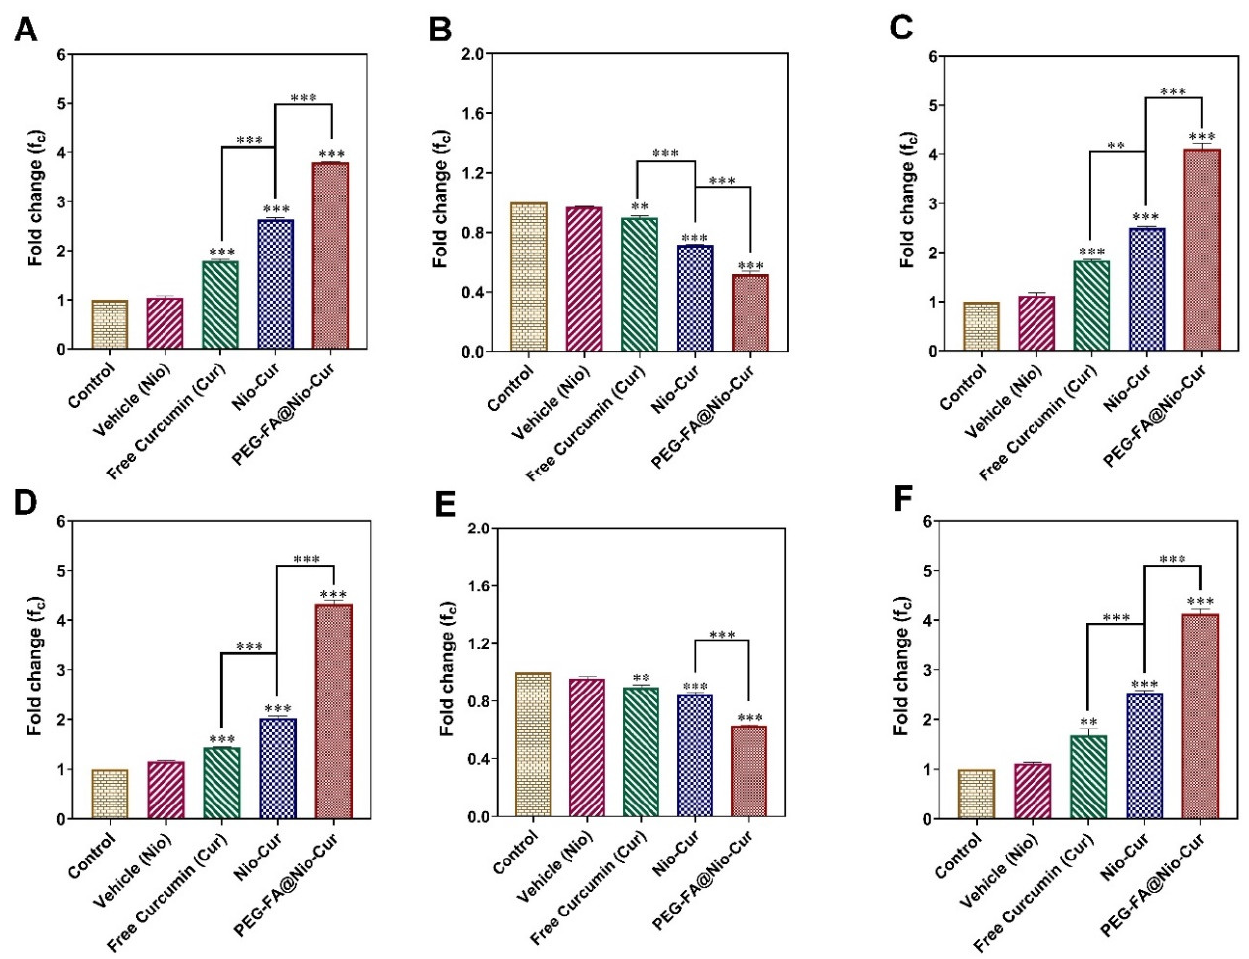
Figure 6. ( A ) Expression levels of Bax, ( B ) Bcl2, and ( C ) p53 genes in MCF7 cells and ( D ) Expression levels of Bax, ( E ) Bcl2, and ( F ) p53 genes in 4T1 cells after those breast cancer cells were exposed to Vehicle (Nio), Free Curcumin, Nio-Cur, and PEG-FA@Nio-Cur ( β -actin as housekeeping gene). Data represent means ± standard deviations ( n = 3). For all charts, ***: p < 0.001; **: p < 0.01; *: p < 0.05.